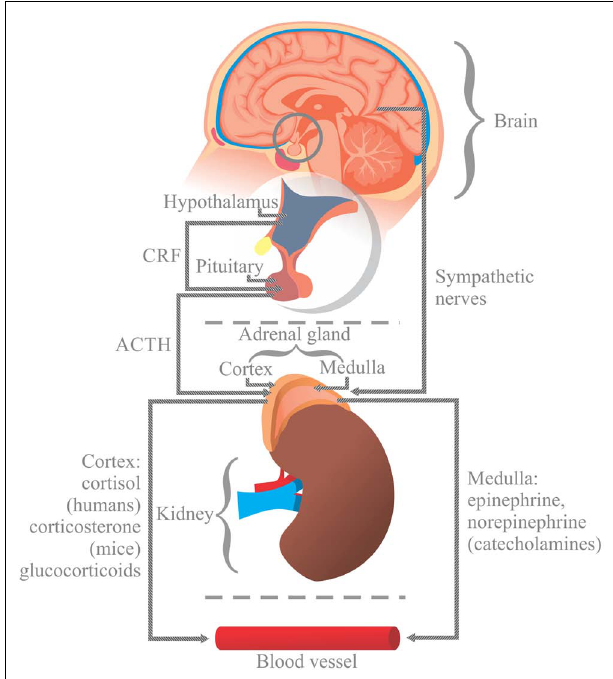
FIGURE 1 | In response to stress, the hypothalamus (H) releases the corticotrophin releasing factor (CRF) into the anterior pituitary (P), causing the release of adrenocorticotropic hormone (ACTH) into the blood flow. ACTH stimulates the generation of glucocorticoids (cortisol in humans and corticosterone in mice) in the cortex of the adrenal gland (A), which are then released into the blood. Stress also activates the autonomic sympathetic nerves in the medulla of the adrenal gland to elicit the production of catecholamines, norepinephrine and epinephrine, which are then released into the blood. Glucocorticoids and catecholamines influence the generation of interleukins, which are involved in the viability and proliferation of immunocompetent gut cells via